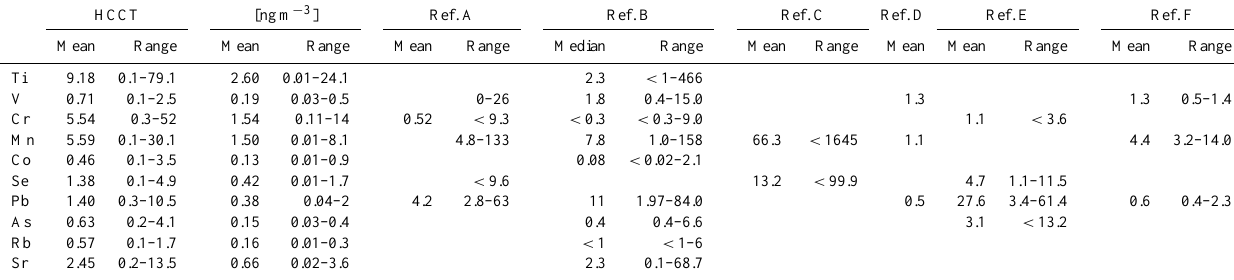
Table 3. Mean and range of trace metal concentrations in cloud water at Mt. Schmücke during HCCT 2010. HCCT [ngm − 3 ] Ref. A Ref. B Ref. C Ref. D Ref. E Ref.